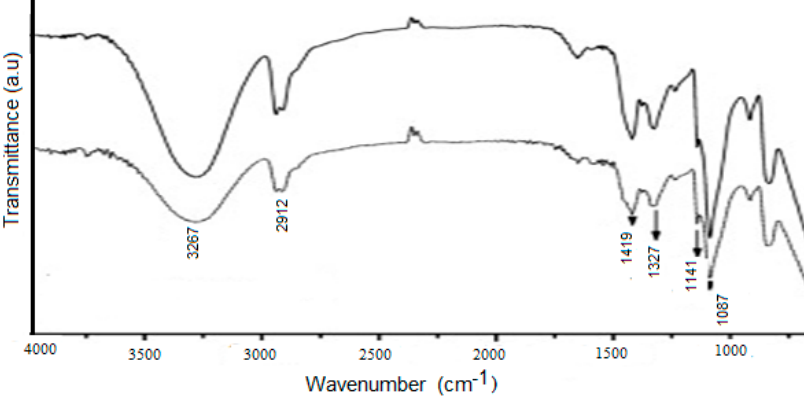
Figure 6. FTIR spectra for PVA ( top ) and PVA cross-linked with GA ( bellow